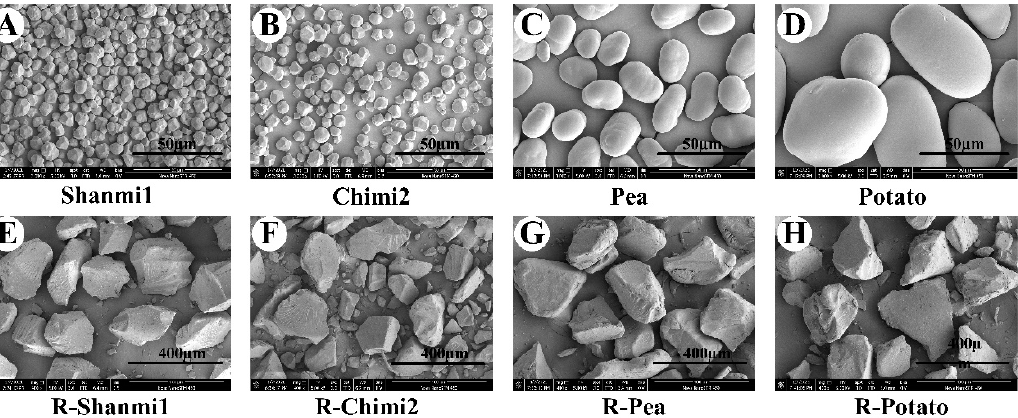
Figure 1. The morphology of NS (natural starch) and RS (resistant starch) granules of proso millet, pea, and potato were observed by SEM (note: the microscopic magnification is 3000 × for NS, the microscopic magnification is 800 × for RS). ( A – D ): NS of waxy proso millet, non-waxy proso millet, pea, potato, respectively. ( E – H ): RS of waxy proso millet, non-waxy proso millet, pea, potato, respectively.